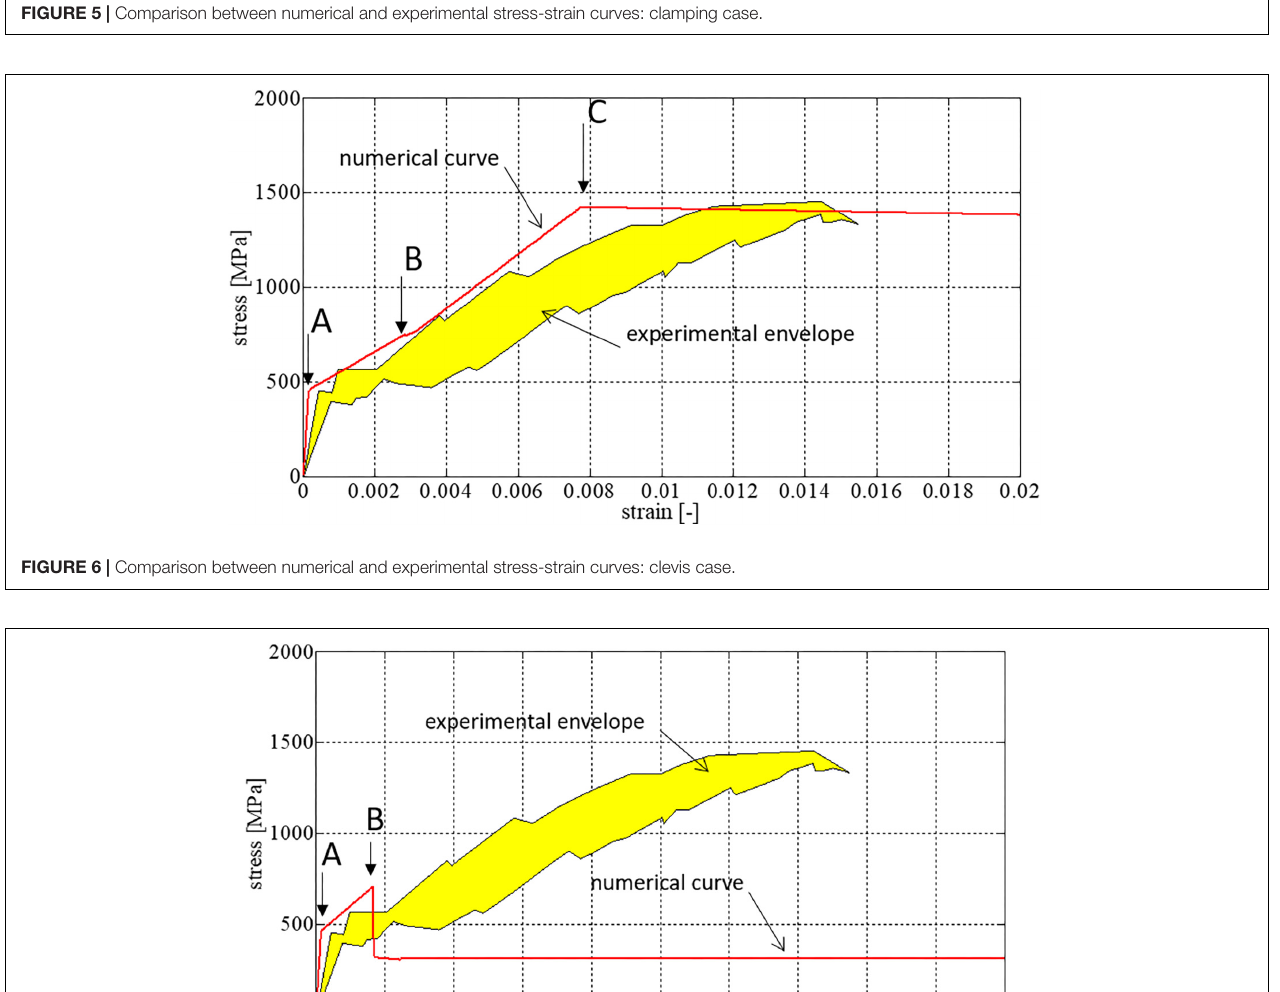
FIGURE 5 | Comparison between numerical and experimental stress-strain curves: clamping case.